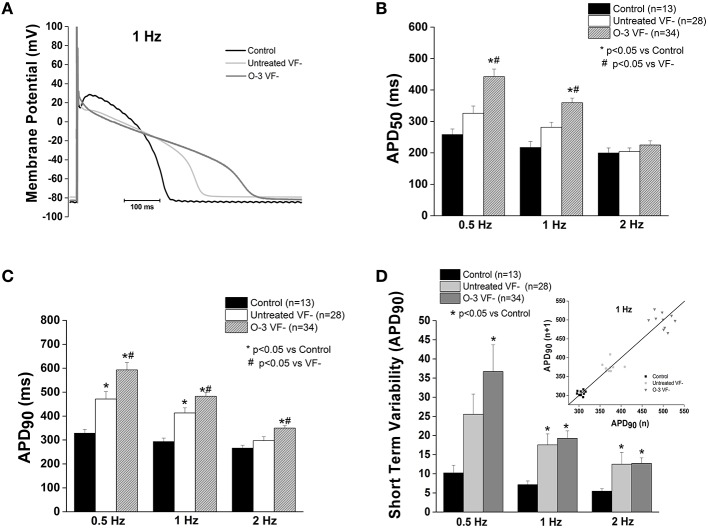
Omega-3 PUFA treatment prolongs repolarization in VF− myocytes. (A) Representative tracings of action potentials of control, untreated VF−, and omega-3 PUFA treated VF− cardiomyocytes. (B) APD50 is significantly increased in the omega-3 PUFA treated VF− myocytes compared to both control and untreated VF− cardiomyocytes (P < 0.05 vs. control and untreated VF− 0.5 and 1 Hz). (C) APD90 is significantly increased in the omega-3 PUFA treated group at all rates; compared to both control and untreated VF− cardiomyocytes (P < 0.05 vs. control and untreated VF− at 0.5, 1, and 2 Hz). (D) Short term variability of APD90 is not further increased by omega-3 PUFA treatment (P < 0.05 vs. control at all rates). Insert: Representative Poincaré Plot of APD90 from control, Untreated VF− and O-3 VF− groups, 6–8 animals per group, n = number of cells.